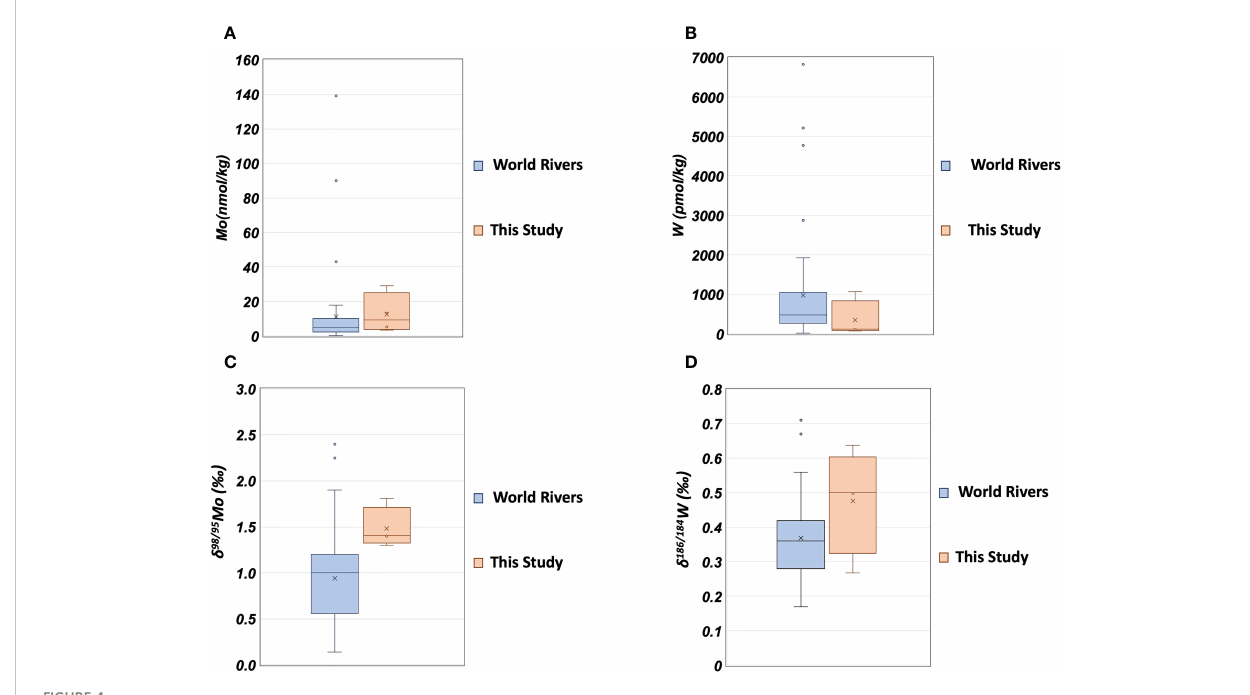
FIGURE 4 The concentrations and isotope ratios of Mo and W in river water. (A) : Mo concentration; blue: world rivers (Archer and Vance, 2008; Firdaus et al., 2008; Neubert et al., 2011), orange: this study. (B) : W concentration; blue: world rivers (Firdaus et al., 2008; Yang et al., 2022), orange: this study. (C) : d 98/95 Mo; blue: world rivers (Archer and Vance, 2008; Neubert et al., 2011), orange: this study. (D) : d 186/184 W; blue: world rivers (Yang et al., 2022), orange: this